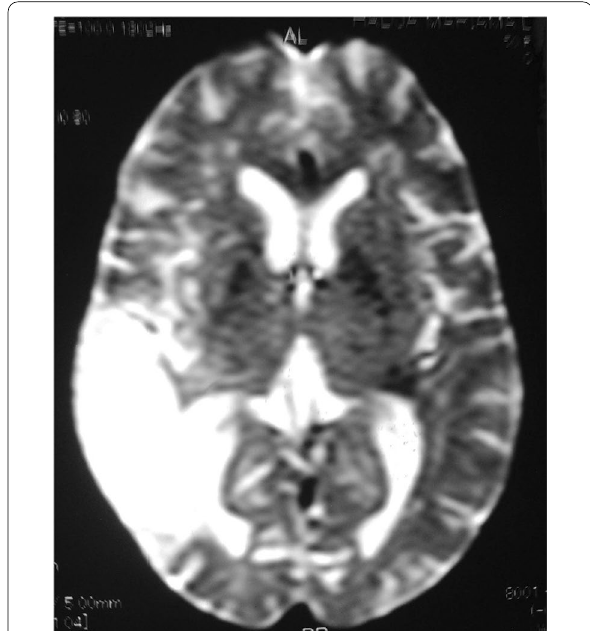
Fig. 4 T2-weighted MRI visualises cortical atrophy with dilation of the furrows in the right hemisphere and hypersignal of the white